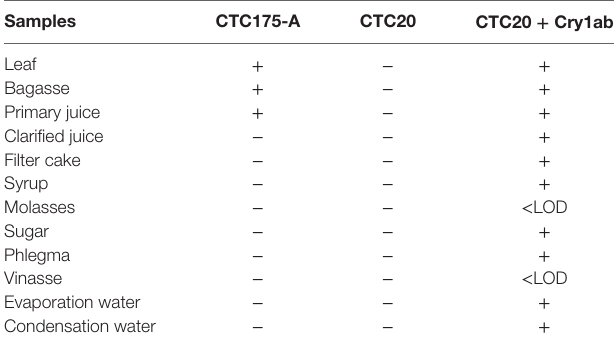
TaBle 10 | Total protein quantification after Bradford extraction in fractions of laboratory sugarcane processing. sample